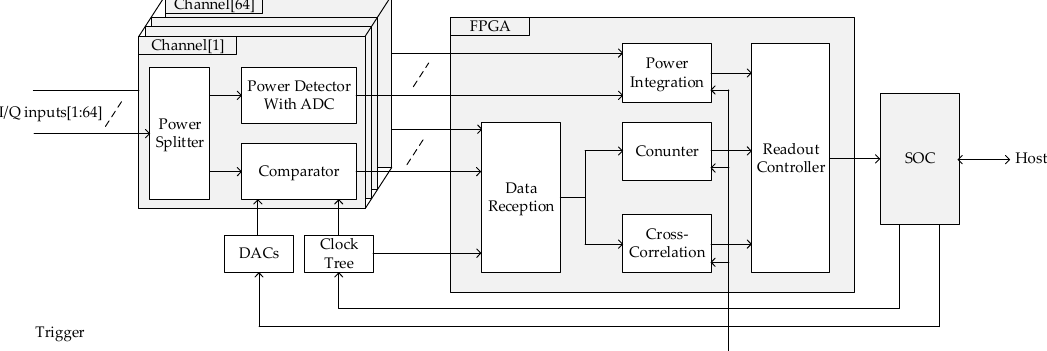
Figure 5. Block diagram of the correlation system.